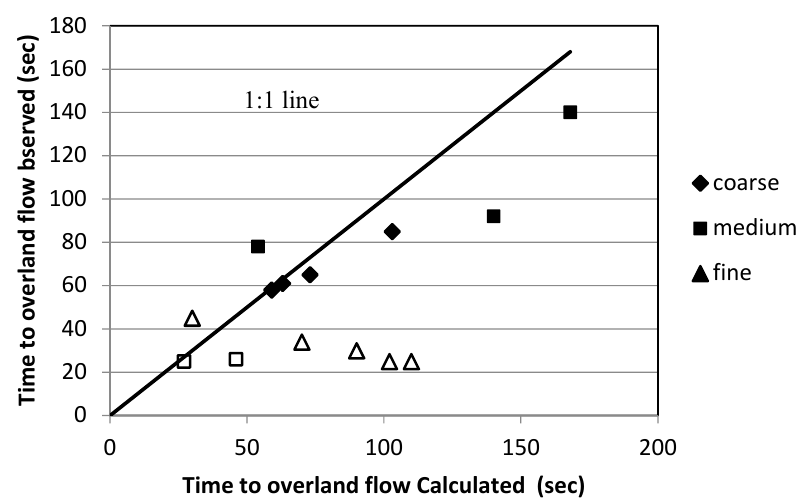
Figure 4. Observed and calculated time to saturation overland flow (black symbols) and Hortonian overland flow (open symbols).